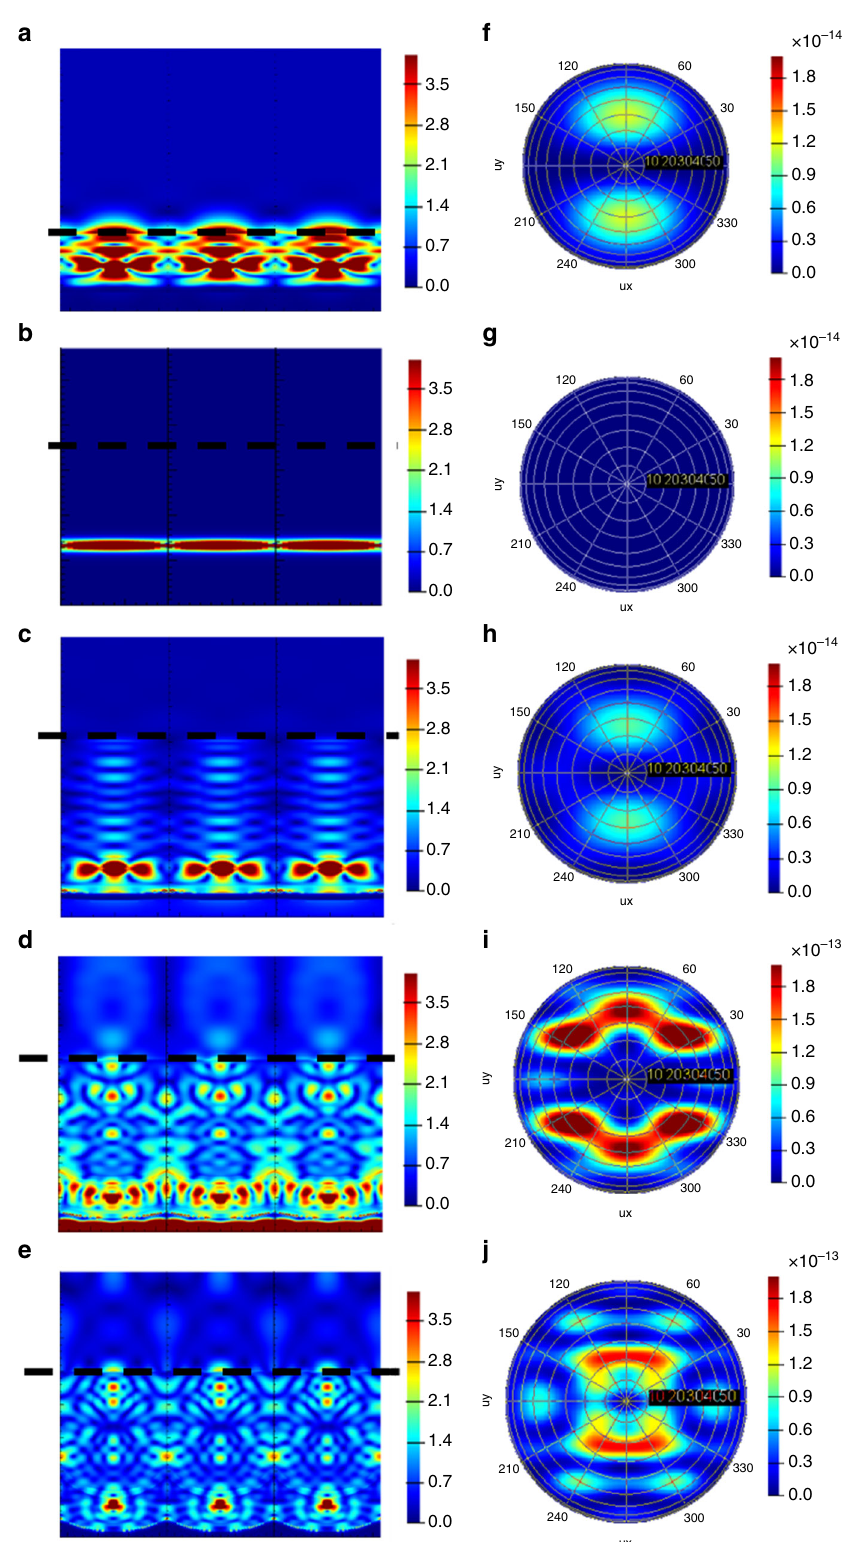
Fig. 5 Cross-sectional E 2 intensities and far- fi eld E 2 intensities. Cross-sectional E 2 intensity (V m − 1 ) 2 of a planar, b P100, c P500, d P1000 and e P1500 AAM devices. Dash lines show the light output plane. Simulated far- fi eld E 2 intensity of f planar, g P100, h P500, i P1000 and j P1500 AAM devices. For f , g and h the color bar upper limit is 2 × 10 − 14 (V m − 1 ) 2 . For i and j , the color bar maximum is 2 × 10 − 13 (V m − 1 )